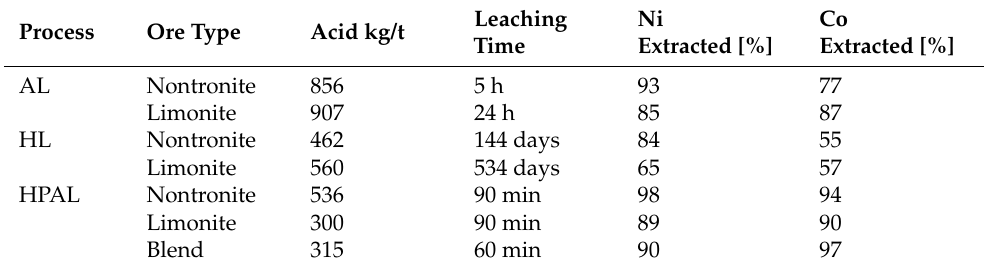
Table 6. Process selection for Gördes laterite deposit